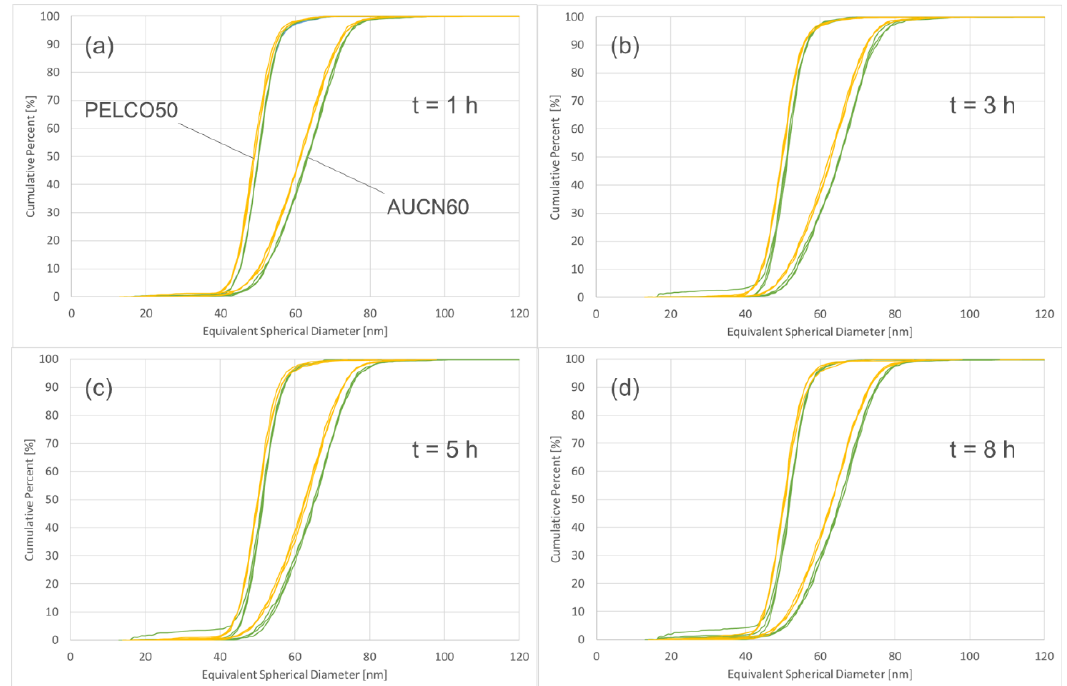
Figure 4. Cumulative number size distributions of surface treated and non-surface treated particles at various time inter- vals ((a) = 1 h, (b) = 3 h, (c) = 5 h, (d) = 8 h), diluted in ultrapure water (green lines) and in 1.5 mM sodium citrate (yellow line). lines) and in 1.5 mM sodium citrate (yellow